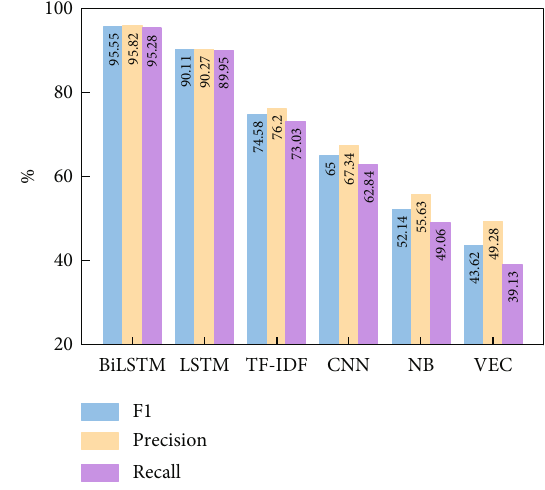
Figure 15: Flight intent labels detected by BiLSTM model and actual labels as marked in the data.